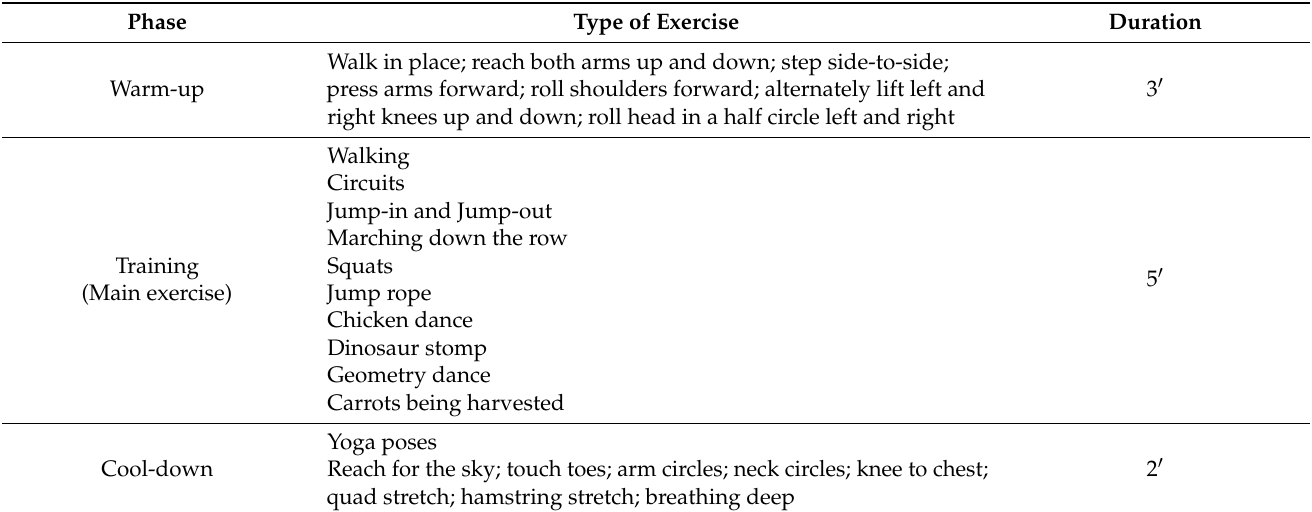
Table 1. Active and recess break